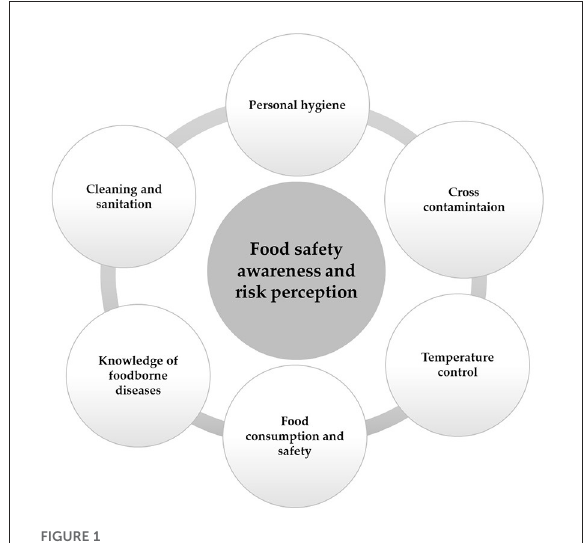
FIGURE1 Survey food safety awareness